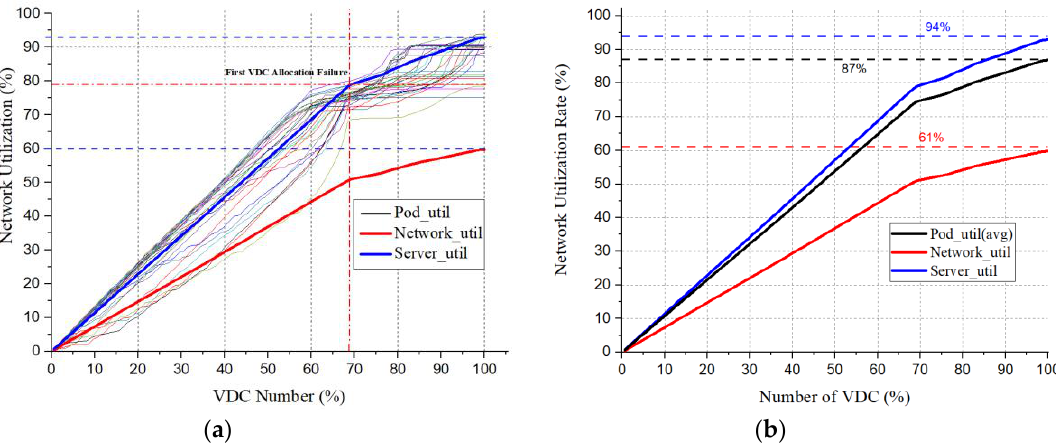
Figure 10. Utilization of Network. (a) collect statistics of network utilization; (b) our proposed algorithm for VDC allocation.